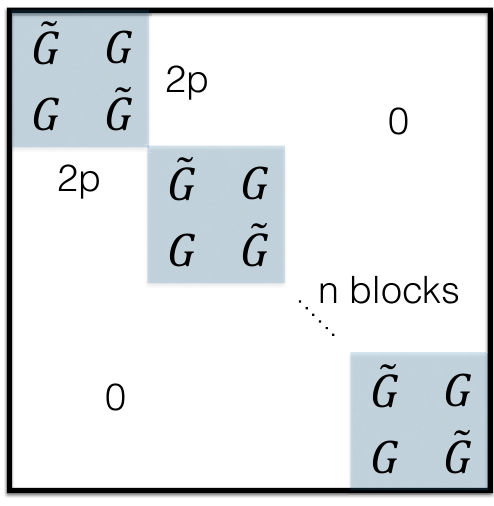
Figure 2 . Structure of the saddle point matrix for calculation of correlation function